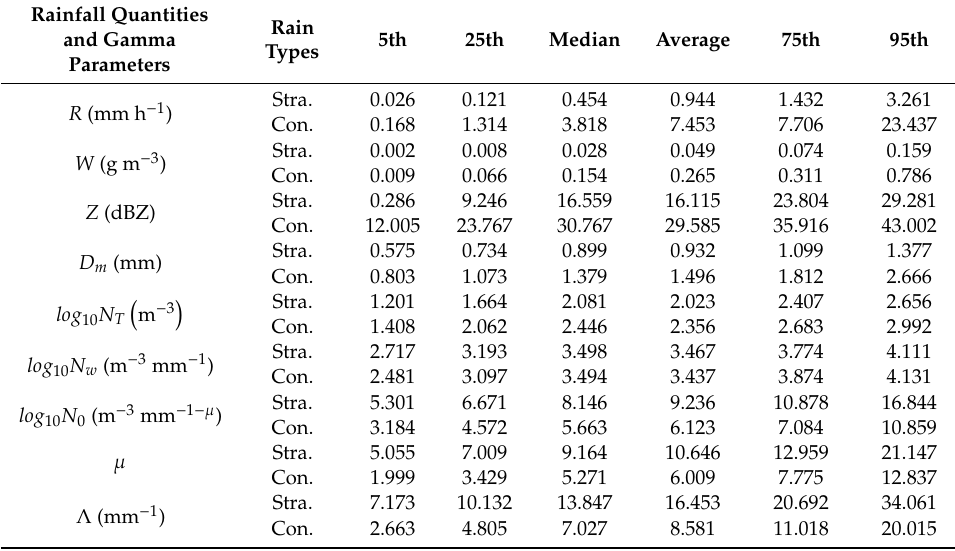
Figure 7. Probability distributions of the integral rainfall physical quantities and gamma distribution parameters. ( a – i ) are the rain rate (R), reflectivity (Z), rainwater content (W), total number concentration ( N T ), mass-weighted mean diameter ( D m ), generalized intercept parameter ( N W ), gamma intercept parameter ( N 0 ), gamma shape parameter ( µ ) and gamma slope parameter ( Λ ). Table 2. The 5th, 25th, 75th, 95th percentiles, medians and averages of integral rainfall physical quantities and gamma distribution parameters for two rain